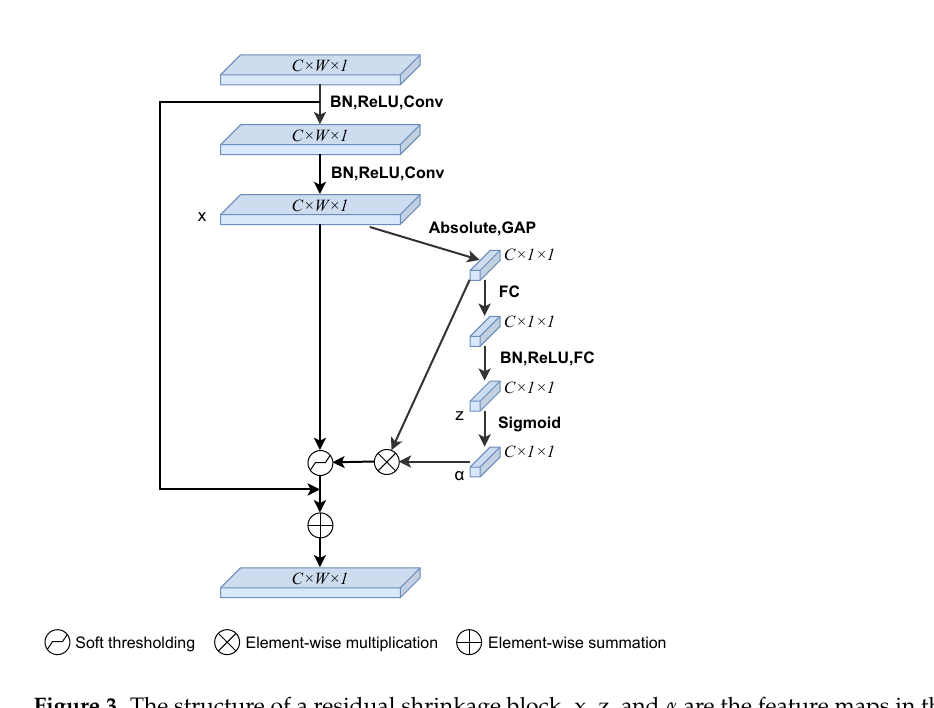
Figure 3. The structure of a residual shrinkage block. x, z, and α are the feature maps in the block, which will be used for threshold